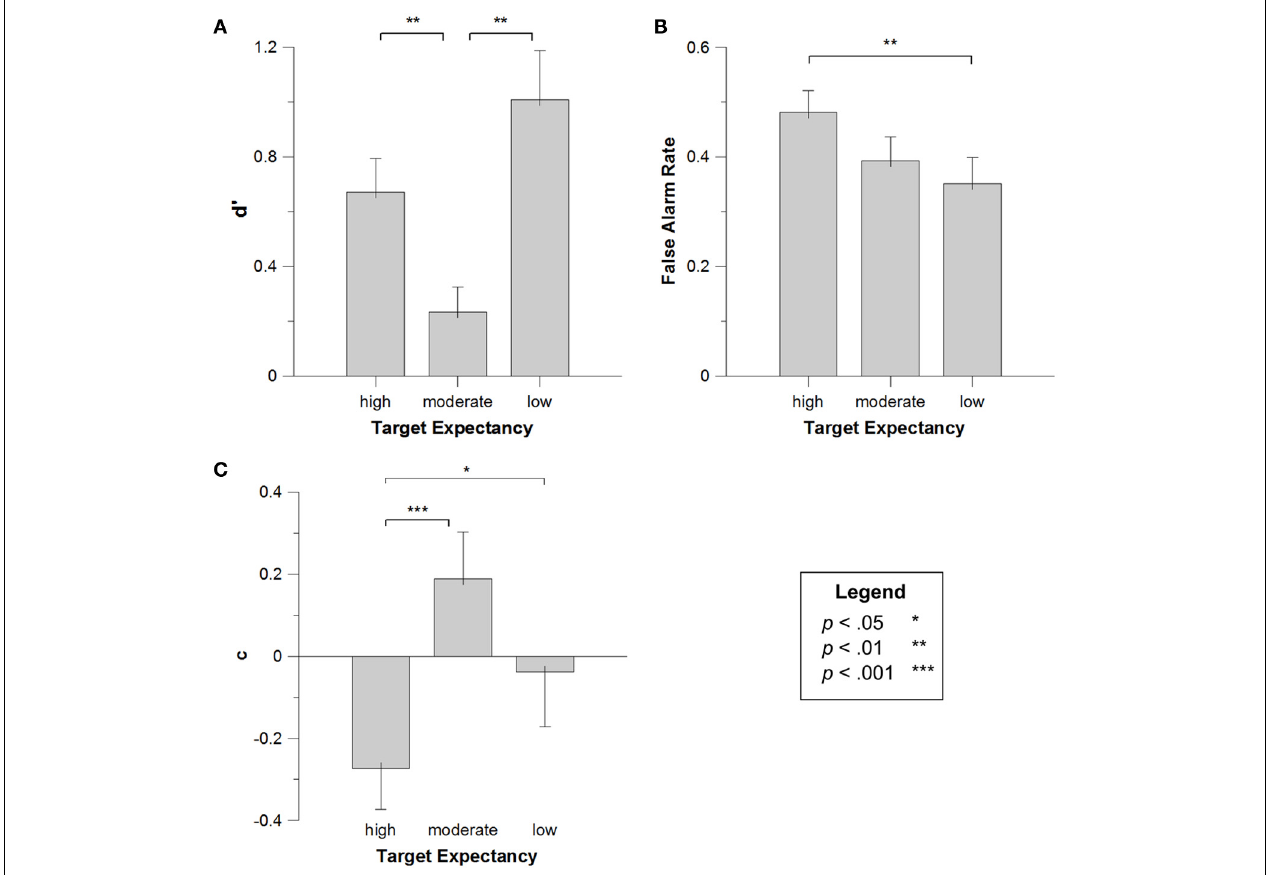
FIGURE 2 | d (cid:2) (A),falsealarmrate(B)andc(C)forhigh,moderate,andlowexpectancytargetsinExperiment1.